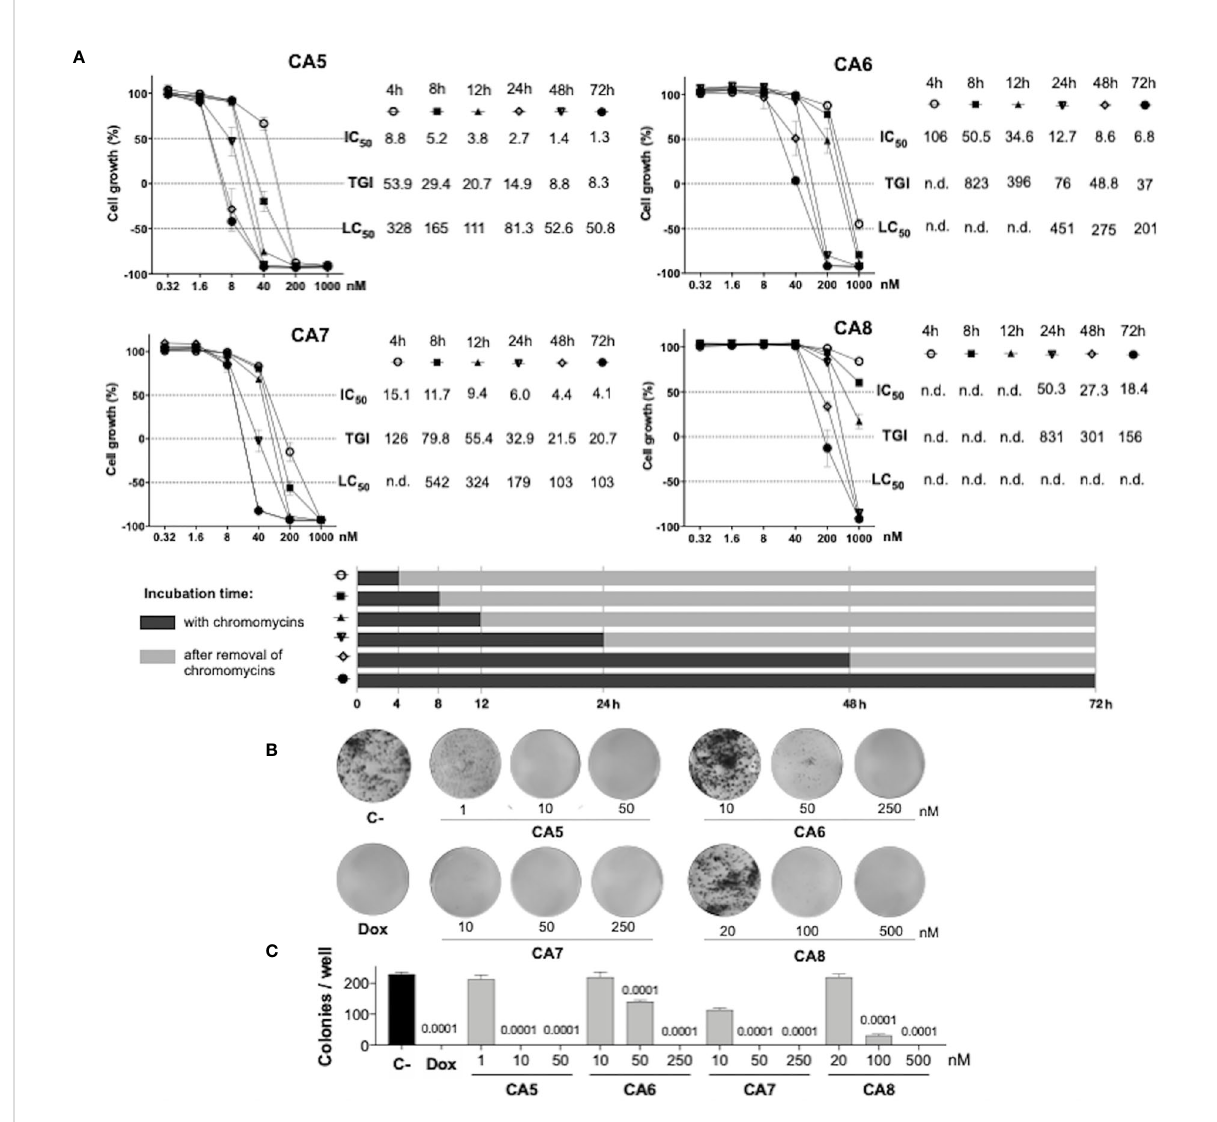
FIGURE 1 Antiproliferative pro fi le of chromomycins A 5-8 on metastatic melanoma B16-F10 cell line over time. (A) , Graphs showing the antiproliferative activity of CA 5-8 after different exposure periods by the SRB assay. Inhibition concentration mean (IC 50 ), total growth inhibition (TGI), and lethal concentration mean (LC 50 ) values in nanomolar (nM) were obtained from interpolation of non-linear regression of normalized absorbance of 3 experiments performed in triplicate. (B) , Representative photos of the clonogenic assay, and (C) , Number of colonies represented as the mean ± standard deviation. 0.05% DMSO (C-) and 0.6 µM doxorubicin (Dox) were considered as a negative control and positive control, respectively. Statistical differences of treated groups versus C- are expressed as p values indicated above the columns of the